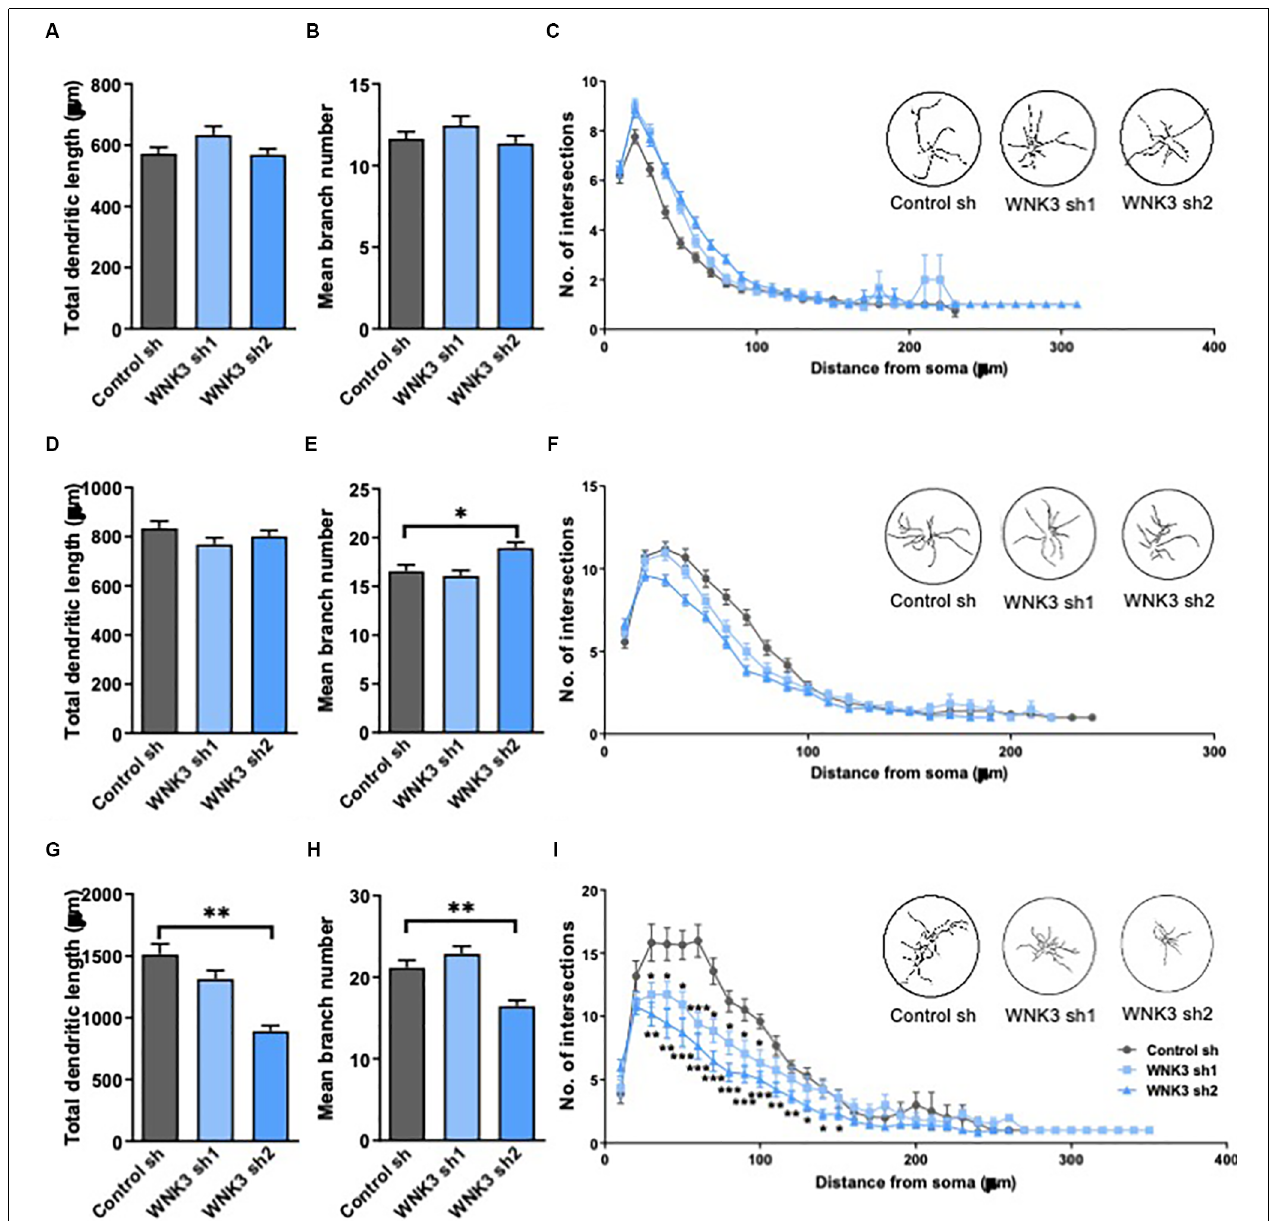
FIGURE 4 | Morphological characterization of WNK3 knockdown in cultured hippocampal neurons. (A,B) Quantification of total dendritic length (A) and the number of dendritic branches (B) of control sh, WNK3 sh1, and sh2 neurons at DIV3, n = 55, 46, 55 neurons from three batches of cultures. (C) Sholl plot comparing the dendritic arbors of control sh, WNK3 sh1, and sh2 neurons at DIV3. The x-axis represents the distance from the cell body, while the y-axis represents the number of intersections of a tracing with a particular Sholl shell. The insets show representative tracings of neurons superimposed on circles denoting Sholl shells, n = 50 neurons in each group. (D–F) Quantification of total dendritic length (D) , number of dendritic branches (E) ( n = 51, 57, 53 neurons from three batches of cultures), and the number of intersections (F) of control sh, WNK3 sh1 and sh2 neurons ( n = 50 neurons in each group) at DIV7. (G,H) Quantification of total dendritic length (G) number of dendritic branches (H) of control sh, WNK3 sh1 and sh2 neurons at DIV14, n = 40, 48, 43 neurons from three batches of cultures. ∗ p < 0.05 compared to control sh. One-way ANOVA with Bonferroni post-hoc . (I) the number of intersections of control sh, WNK3 sh1 and sh2 neurons at DIV14 ( n = 10, 13, 15 neurons). Asterisk denotes comparison between control sh and WNK3 sh1, n = 10, 13 neurons; number sign denotes comparison between control sh and WNK3 sh2, n = 13, 15 neurons, ∗ p < 0.05, ∗∗ p < 0.01 and ∗∗∗ p < 0.001. One-way ANOVA with Bonferroni post-hoc .